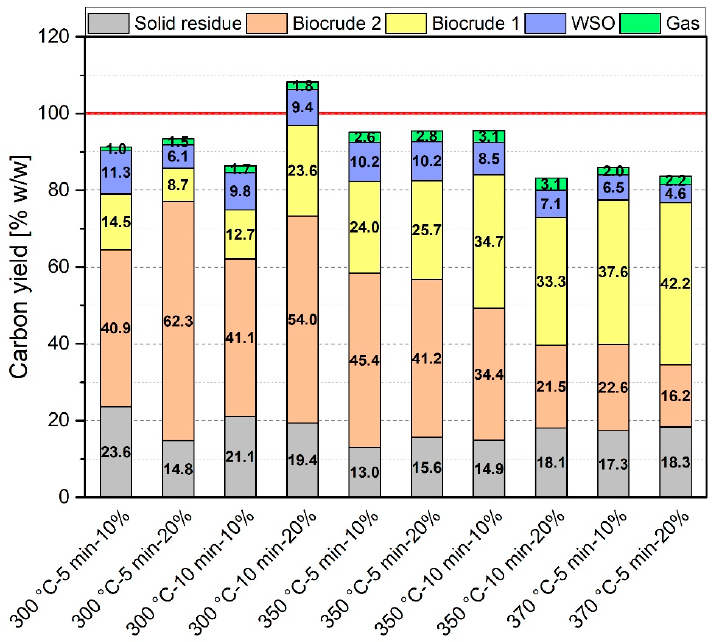
Figure 11. Carbon distribution among HTL products.